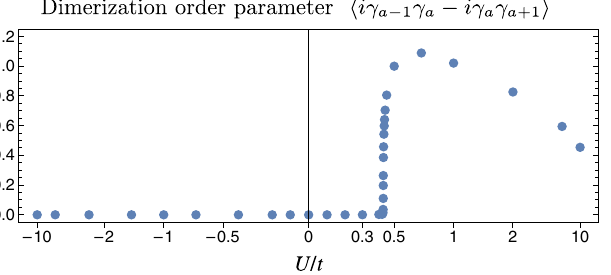
FIG. 4. Dimerization order parameter h i γ sus U=t obtained from DMRG simulations of the model in Eq. (20) with t 0 ¼ 0 . This order parameter corresponds to the fermion mass in the continuum limit. For U=t ≳ 0 . 42799 ð 2 Þ , our simulations capture a gapped, spontaneously dimerized phase for the chain, in agreement with Ref. [87]. At smaller U=t , the chain instead realizes a critical state with central charge c ¼ 1 = 2 . We additionally verify that this critical state extends to large negative U=t values.